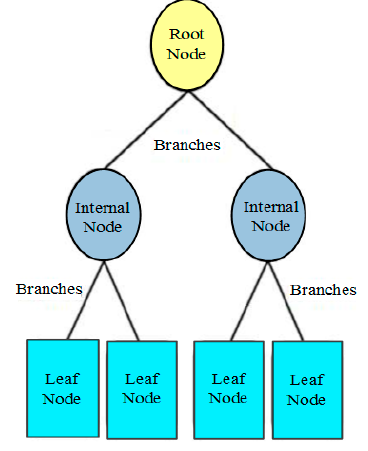
Figure 7. Decision tree layout.